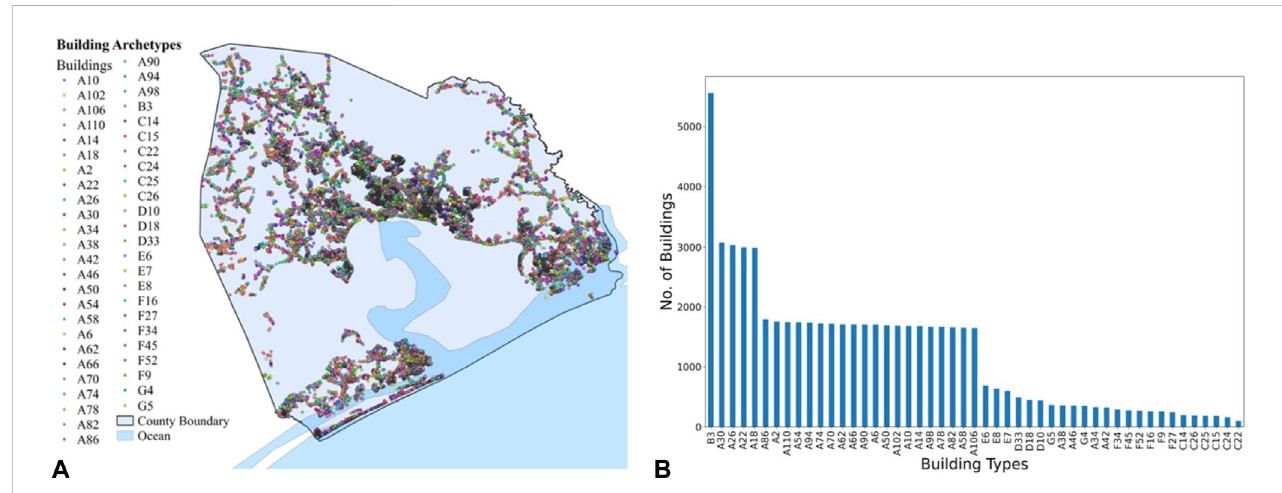
FIGURE 6 Onslow building inventory: (A) spatial distributions, and (B) number of each